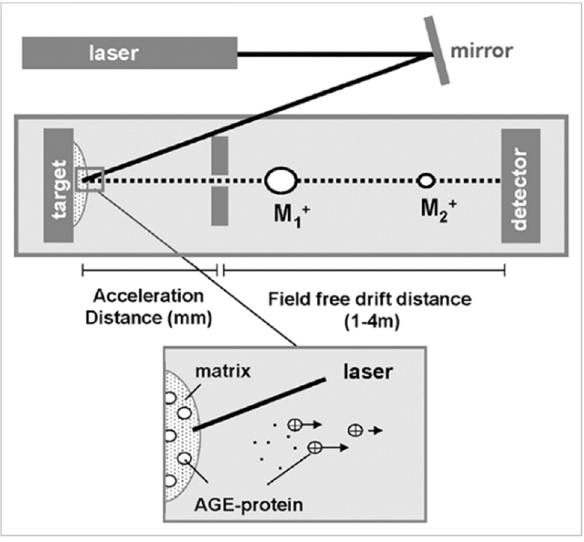
Figure 4: The process by which AGE proteins are detected using MALDI - TOF/MS. A suitable matrix is required to analyze the glycated proteins by MALDI - TOF/MS. A laser pulse hits the glycated proteins and matrix molecules, which absorbs the laser and transfers energy to the proteins/peptides, which then fl y under vacuum to the detector. Reprinted with permission from Kislinger et al. [ 93 ]